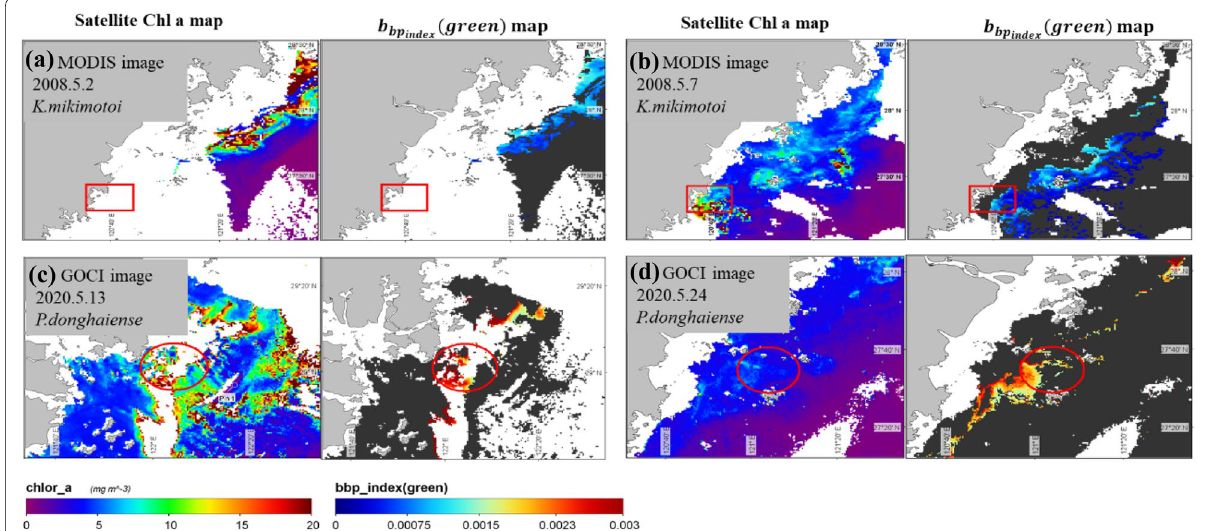
( green ) maps ( a , b ) K. mikimotoi blooms from MODIS images and ( c , d ) P. donghaiense Fig. 5 Satellite imagery derived Chl a maps and b bp_ index blooms from GOCI images, respectively. The highlighted regions (red rectangles and circles) indicate occurrences of K. mikimotoi and P. donghaiense bloom regions that were recorded by the State Ocean Administration (SOA) and the Bulletin of China Marine Disaster from the Zhejiang Ocean ( green ) , respectively. The black pixels indicate area of Forecast. The color bar represents the variation of satellite derived Chl a and b bp_ index non-bloom